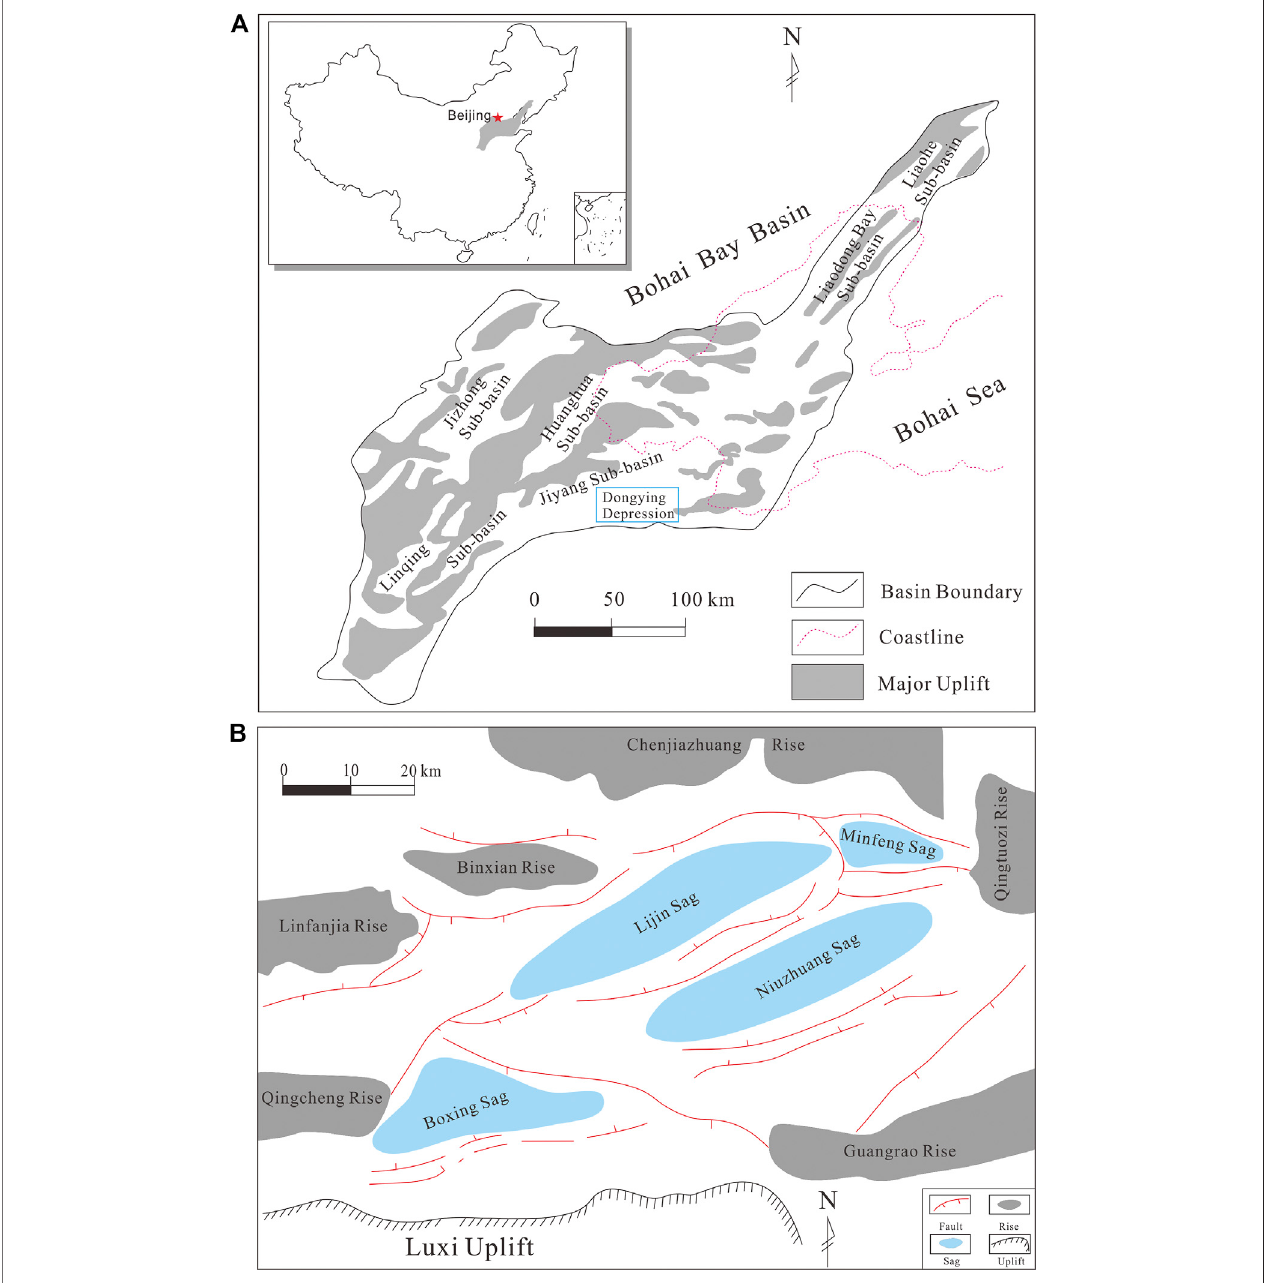
FIGURE3| Locationmapofstudyarea (A) schematicmapofBohaiBayBasinanditslocationinChina. (B) LocationofDongyingDepression(modi fi edafterZhang et al., 2020).